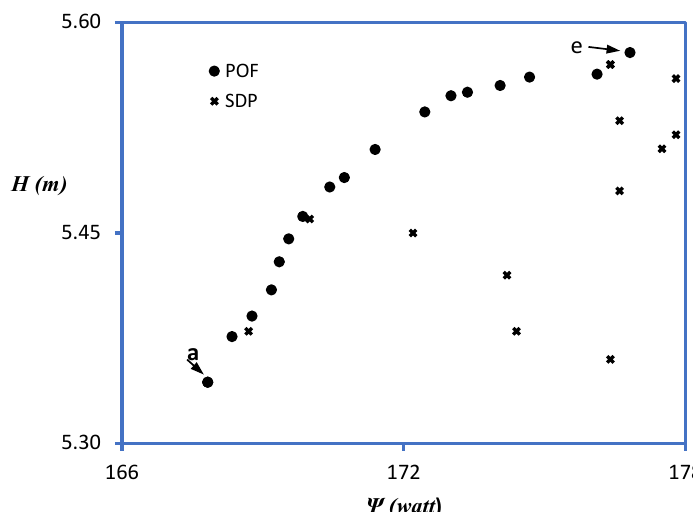
Figure 12. Pareto optimal front for case C1.